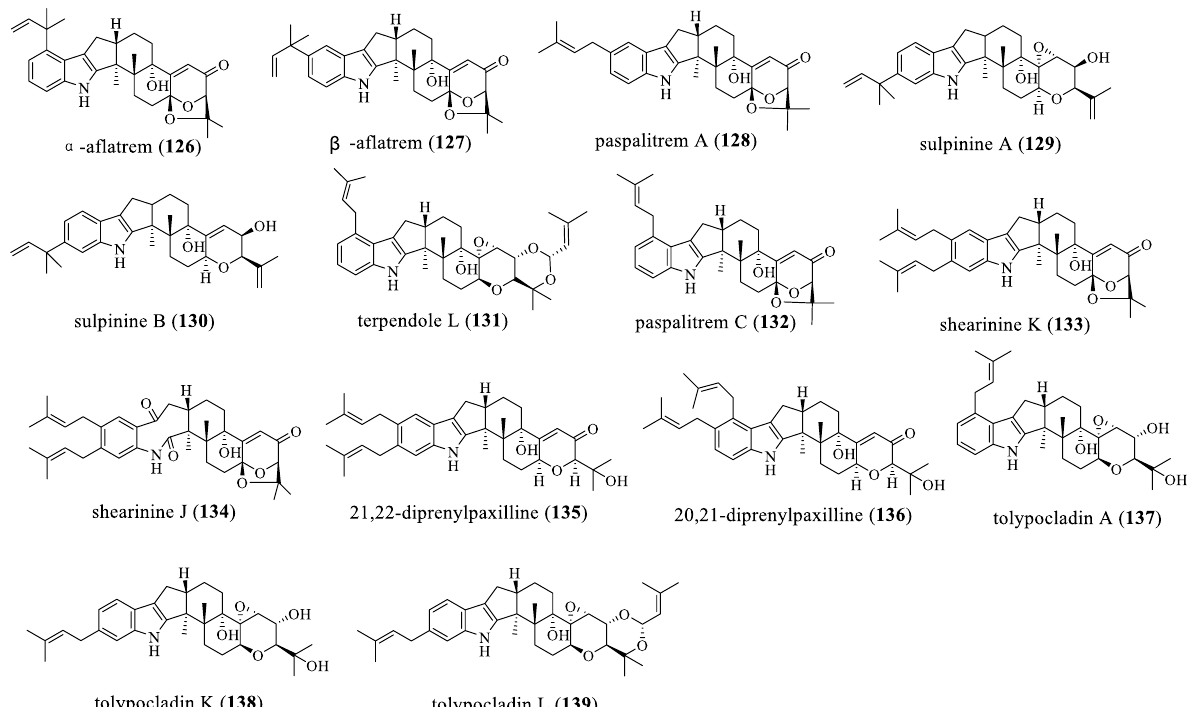
Fig. 9 Chemical structures of paspaline‑type compounds with A‑ring prenylation